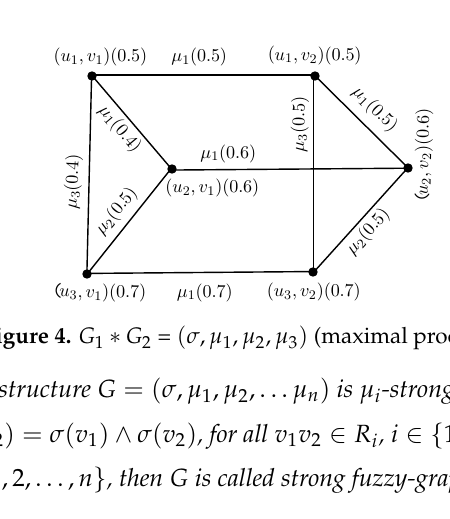
Figure 3: Two Fuzzy Graph Structures G 1 and G 2